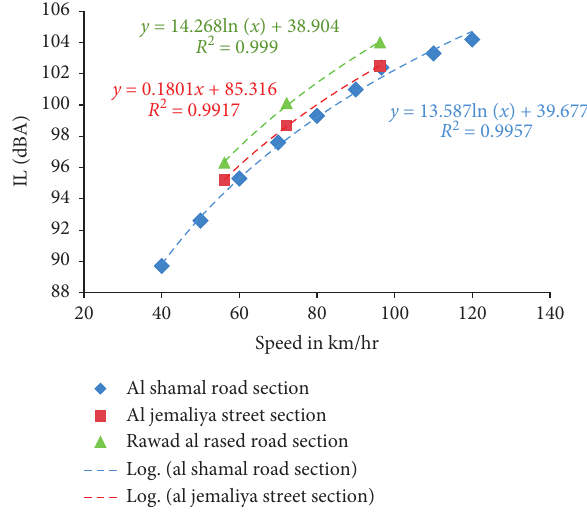
Figure 14: Variation of the intensity level with driving speed for SRTT.